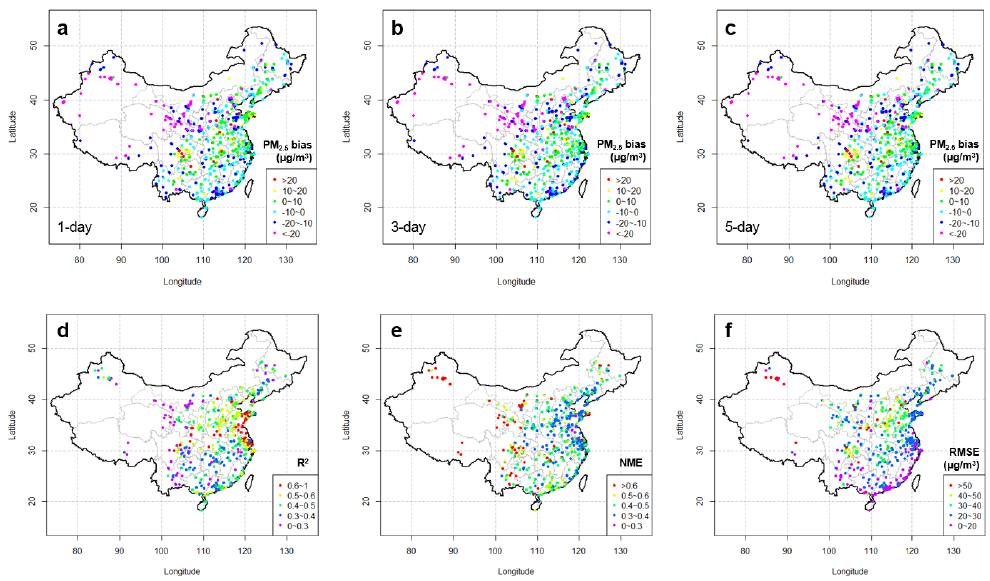
Figure 4. Performance of the raw PM 2.5 model forecasts in predicting observations at avg-monitors in 2016: ( a , b , c ) annual mean biases for the 1, 3, and 5-day lead times and ( d , e , f ) annual mean R 2 , NME, and RMSE for the 1-day lead-time.